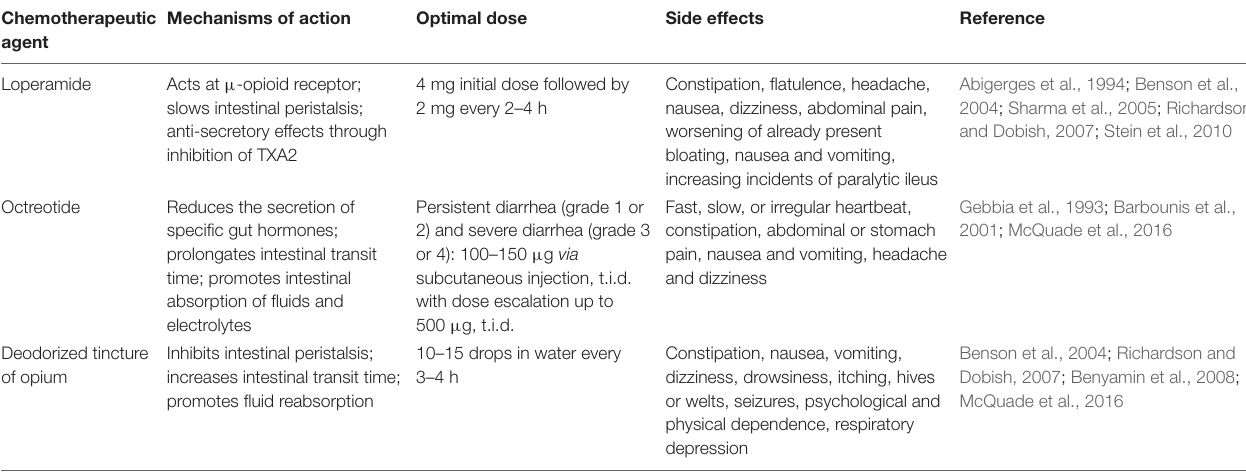
TABLE 1 | Major chemotherapeutic agents for the treatment of CPT-11-induced diarrhea.